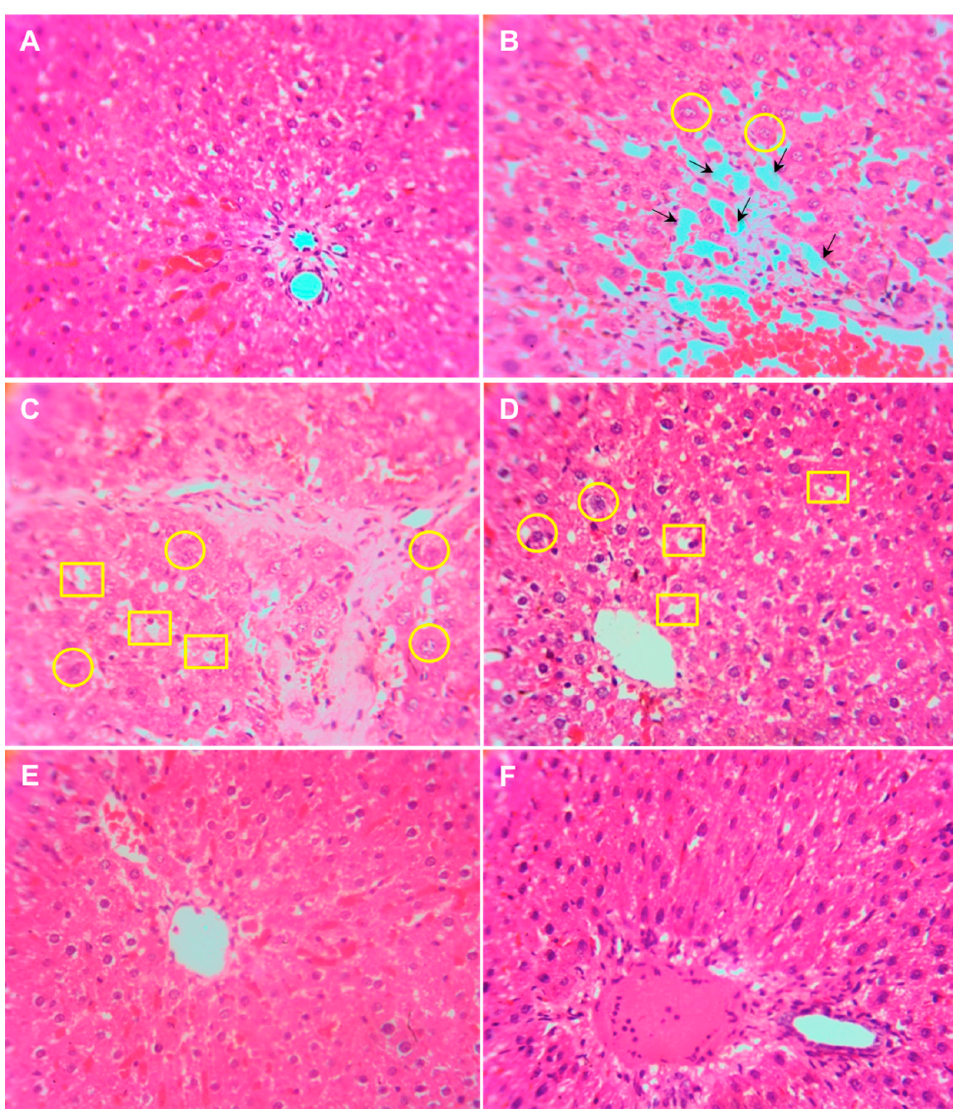
Figure 5. Photomicrographs showing normal architecture of hepatocytes in liver sample obtained from a control animal ( A ), disorganized hepatocytes, cellular inflammation, area necrosis, hepatic sinusoid and pathological nuclear cell division (circle) in animals injected with CCl 4 ( B ), damaged hepatocytes, pathological nucleus cell division and steatosis in animals treated with 25 mg/kg of free curcumin ( C ), mild changes in the architecture, pathological nucleus cell division and mild steatosis in animals treated with 50 mg/kg of free curcumin ( D ) and normal hepatocytes architecture in animals treated with low and high doses of η Cur ( E , F ). Some of the areas showing hepatic sinusoid (arrow), pathological nuclear cell division (circle) and steatosis (square) are marked.